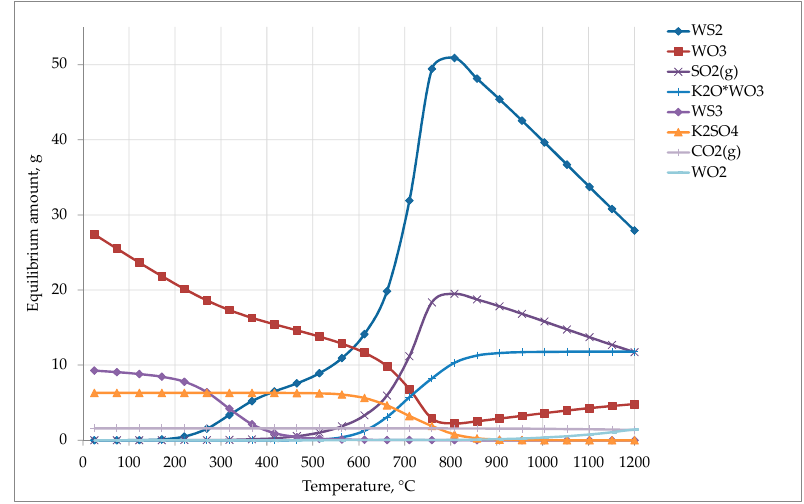
Figure 6. Equilibrium amount of WO 3 –S–K 2 CO 3 reactant system in N 2 gas atmosphere.